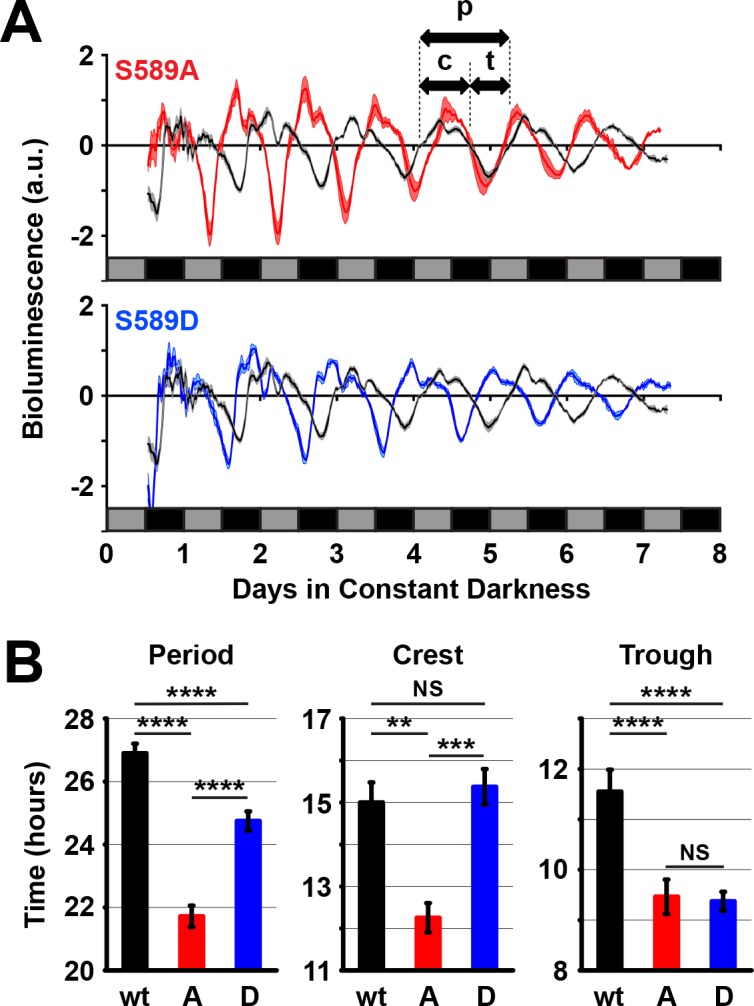
589 substitutions differently regulate per promoter activity in vivo.(A) Flies expressing the indicated transgenic per variant in a per0 background and the luciferase gene driven by the per promoter were measured for bioluminescence activity in constant darkness. Grey boxes represent subjective day, black boxes represent subjective night. S589A (red line) and S589D (blue line) were compared to wt per rescue (black line) flies. N = 5 groups of 80 flies. Thickness of the curve reflects SEM. Double-headed arrows use the wild type signal to illustrate a full period of bioluminescence (p), the width of the crest (c) or the width of the trough (t). (B) The full period of bioluminescence, and the crest and trough widths measured in panel A are plotted. w: wild type PER (black bars), A: S589A (red bars), D: S589D (blue bars). Bars represent means, ±SEM. **p<0.01. ***p<0.005. ****p<0.001. NS: not statistically significant. Significance was measured by t-test.